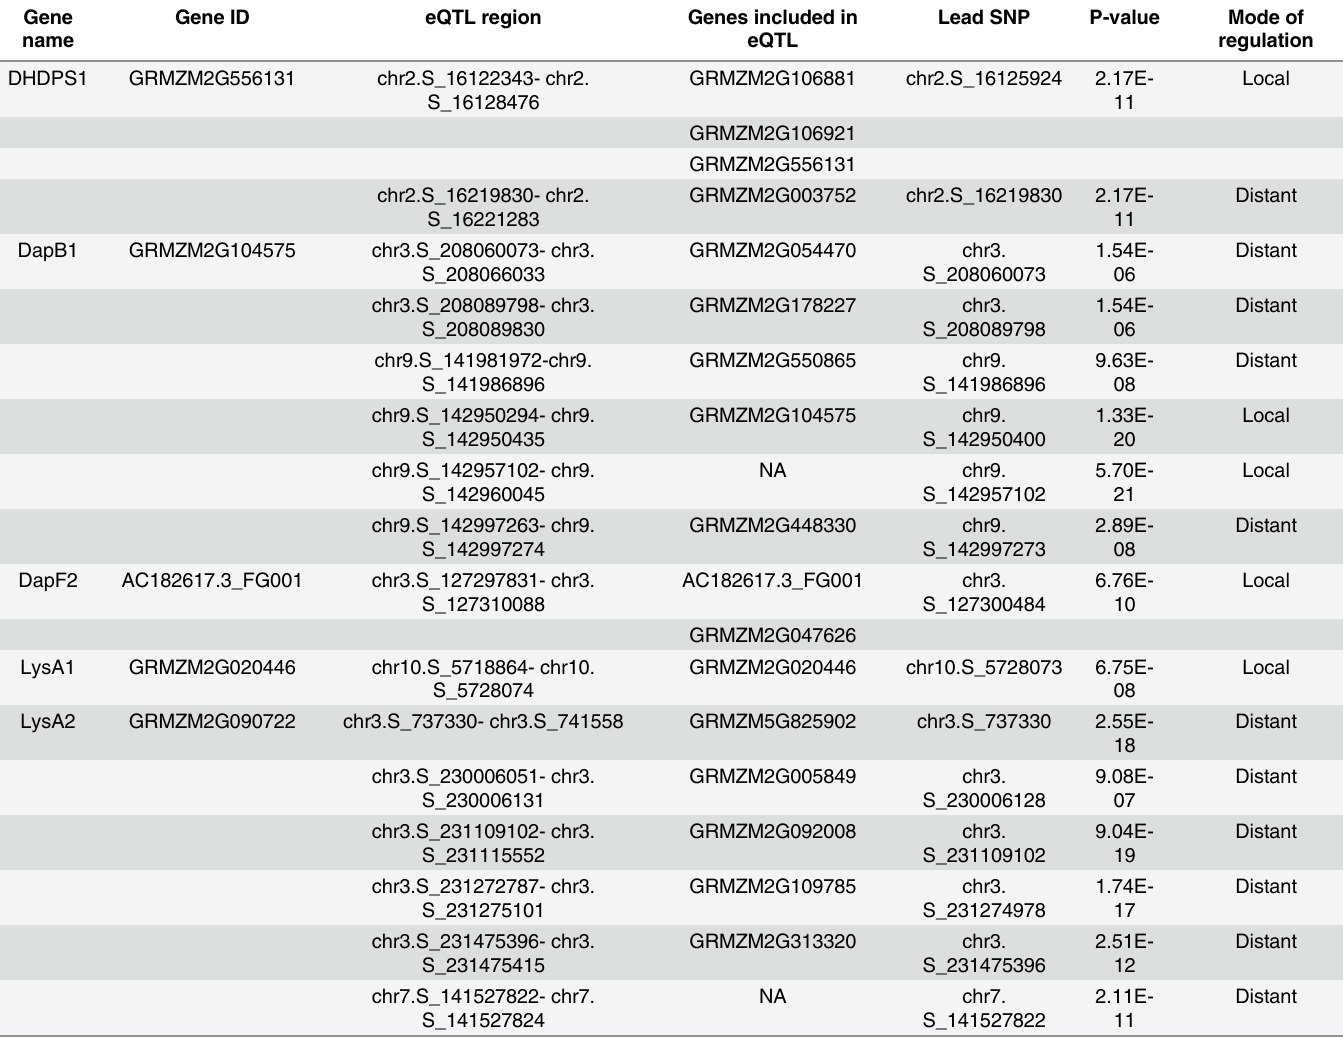
Table 2. Regulation of LBPGs for maize seed Lysine